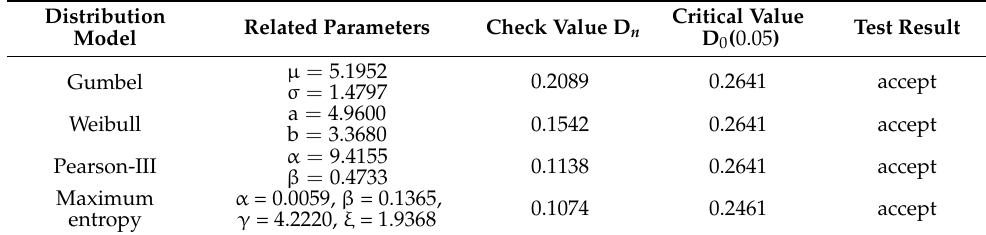
Table 4. K-S test results and related parameters.